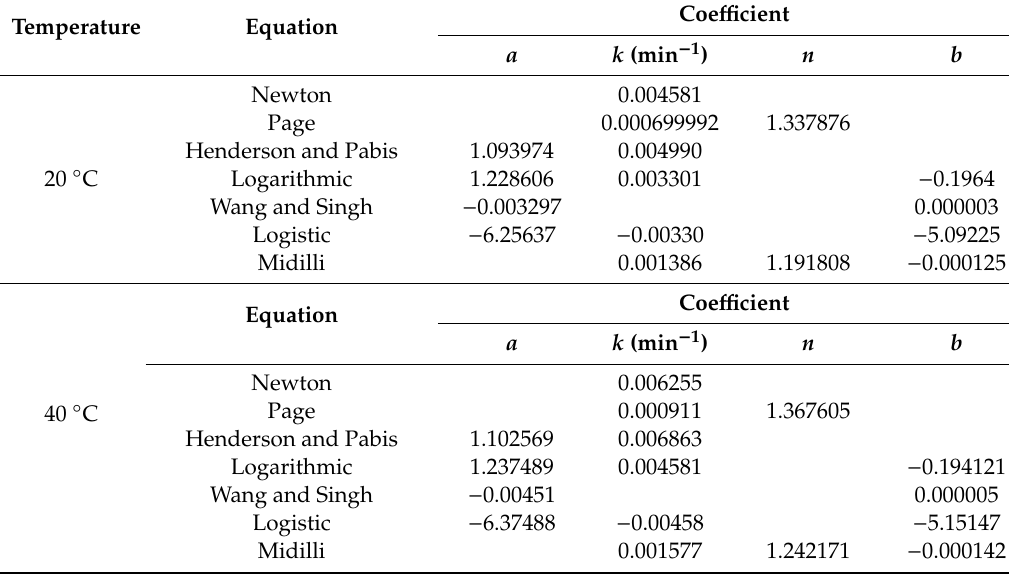
Table 4. Values corresponding to di ff erent models describing the freeze–drying process of wild strawberry